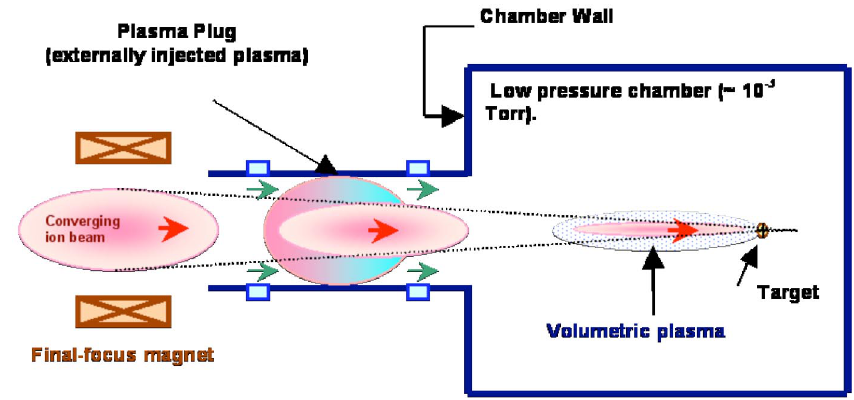
FIG. 4. (Color) Generic layout of a plasma-neutralization system.